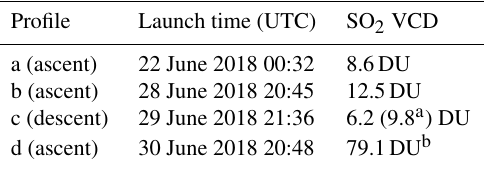
Table 2. The SO 2 vertical column density (VCD) for profiles shown in Fig. 8 from BISOS in June 2018. For profile c, the descent profile VCD is reported for the flight without extrapolation (shown with- out parentheses) and using linear extrapolation assuming the SO 2 concentration to be 0ppbv at sea level (shown in